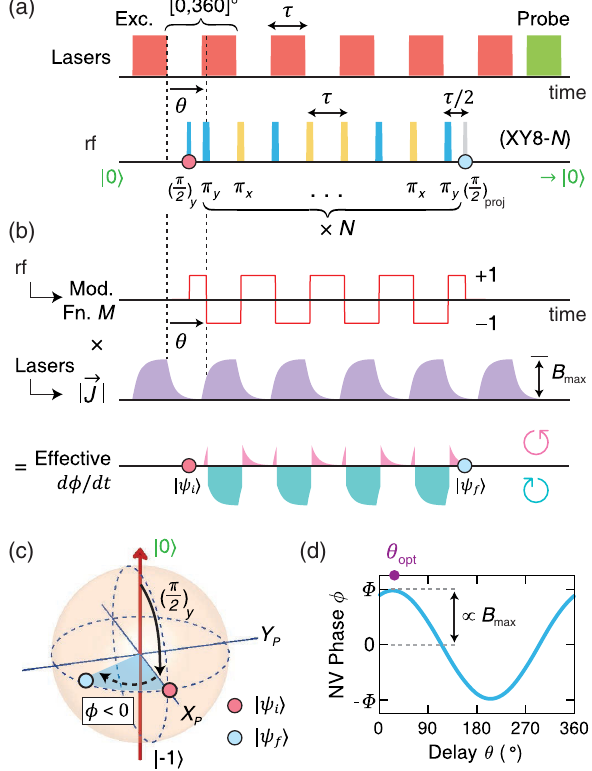
FIG. 2. Protocol for detecting ac photocurrents. (a) Synchron- ized photoexcitation and dynamical decoupling sequence. The 1 = 2 τ , while an MoS 2 excitation laser is gated at a rate ν exc ¼ XY8- N dynamical decoupling sequence with spacing τ between the π pulses is applied to the NV center spin. The delay between the first π pulse and the end of the last photoexcitation pulse is denoted as the phase θ (e.g., θ ¼ 200 ° for the pulse trains shown). The rotation axes ( x or y ) of the rf pulses are color coded. The axis for the last π = 2 projection pulse varies depending on which projection ( X P or Y P ) of the final superposition state is measured by the probe laser. (b) Schematic of the modulation function M ð t Þ ⃗ J and photocurrent density j ð t Þj corresponding to the rf and photoexcitation pulses, respectively, shown in (a). The photo- current density displays a rise and fall time and produces a time- varying magnetic field with amplitude B along the NV axis. max The phase ϕ acquired by the NV center is the integral of the product of M ð t Þ with the photocurrent magnetic field (product shown in bottom trace). (c) Bloch-sphere representation of NV spin precession. The ð π = 2 Þ y pulse prepares the initial state j ψ i i , which evolves to j ψ f i during the sensing duration. (d) Simulated dependence of ϕ on the delay θ for a sinusoidal magnetic field. The maximum phase Φ is acquired at the optimal delay θ and is opt determined by the magnitude B of the local magnetic field max produced by the